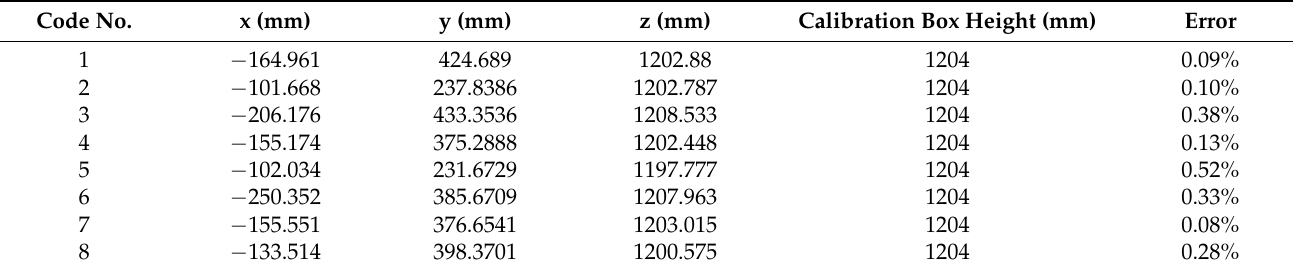
Table 5. Measurement accuracy verification of calibration box image